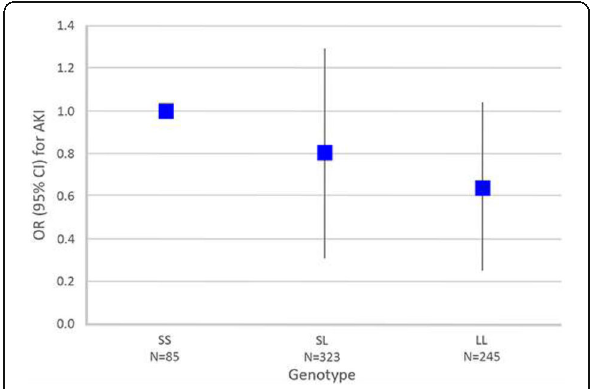
Fig. 1 (abstract 0068). Risk of AKI according to